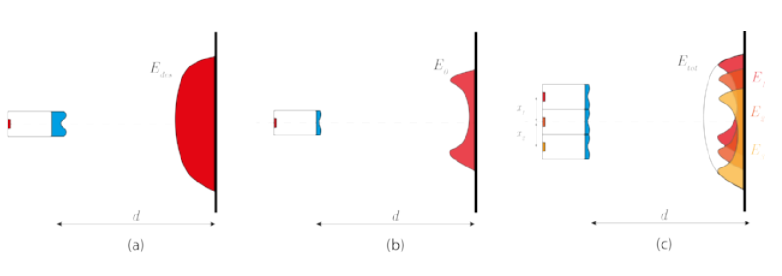
Figure 1. (a) A single illumination system projects a desired irradiance distribution E des onto a plane a distance d away. (b) A single sub-system generates an intermediate irradiance distribution E 0 (c) The combination of multiple illumination systems all projecting a irradiance distribution E k add up to a total irradiance distribution E tot ≈ E des .